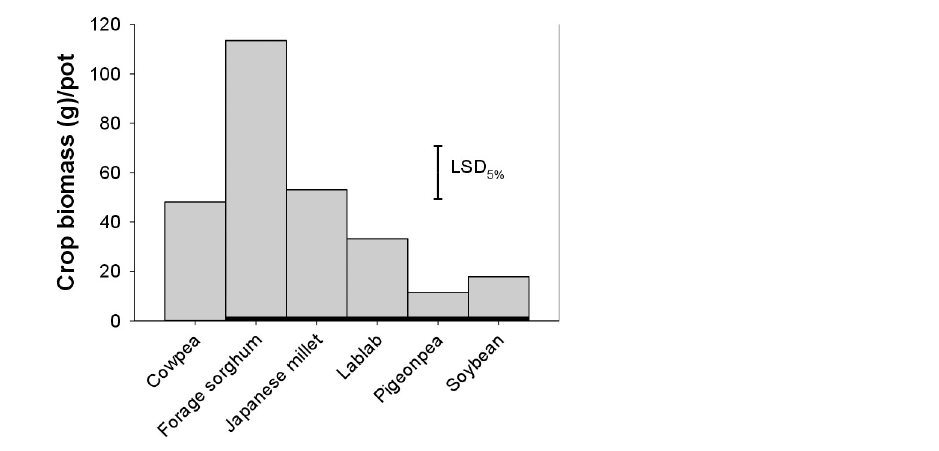
Fig 8. Biomass of various cover crops used in the present